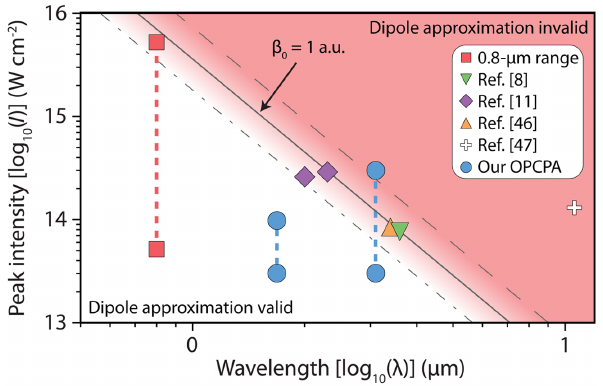
FIG. 4. The validity of the dipole approximation as a function of the driving wavelength and peak intensity. The limit where the magnetic field causes the electron motion perpendicular to the laser polarization to become greater than a Bohr radius is given by the solid black line ( β 0 ¼ 1 . 0 a : u : ). Also shown are the limits for β ¼ 0 . 5 a : u : (dot-dashed line) and β ¼ 2 . 0 a : u : (dashed line). 0 0 Most 0 . 8 - μ m experiments are performed in the “ valid ” region (red squares) while many near-IR and mid-IR experiments are close to the limit (Ref. [11], purple diamonds; Ref. [46], orange upwards triangle; Ref. [8], green downwards triangle, and Ref. [47], white cross). The range of intensities available to the two outputs of our OPCPA, and therefore the regions over which we can probe the dipole approximation, are presented by blue circles.